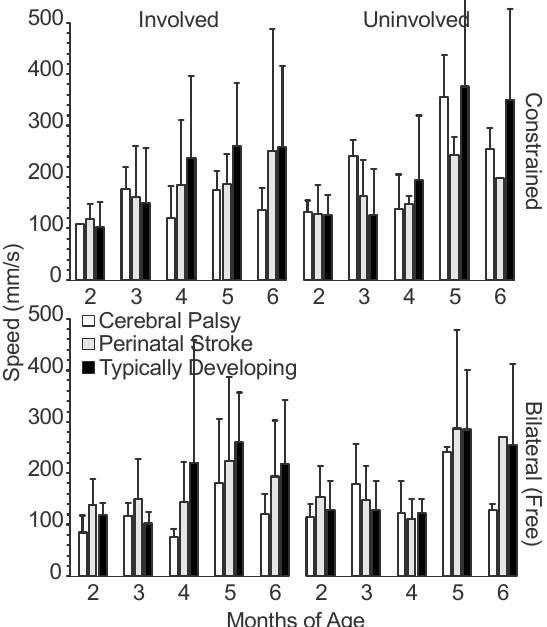
Figure 5. Mean movement speed by age, side, and condition. For typically developing infants, the left arm is plotted alongside the involved limb and the right arm is plotted alongside the uninvolved limb. Error bars show 1 standard deviation.